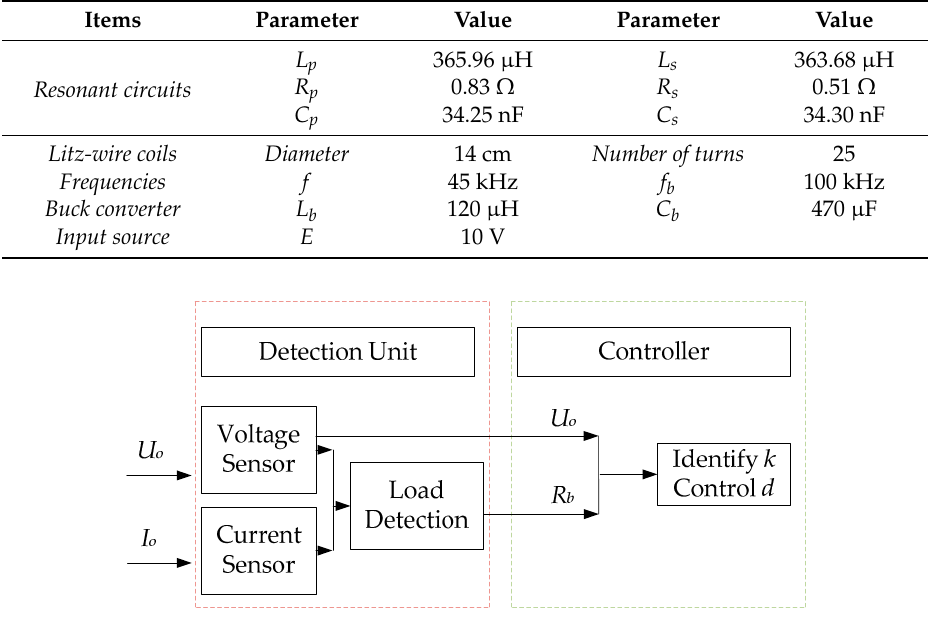
Table 1. Parameters of the system.